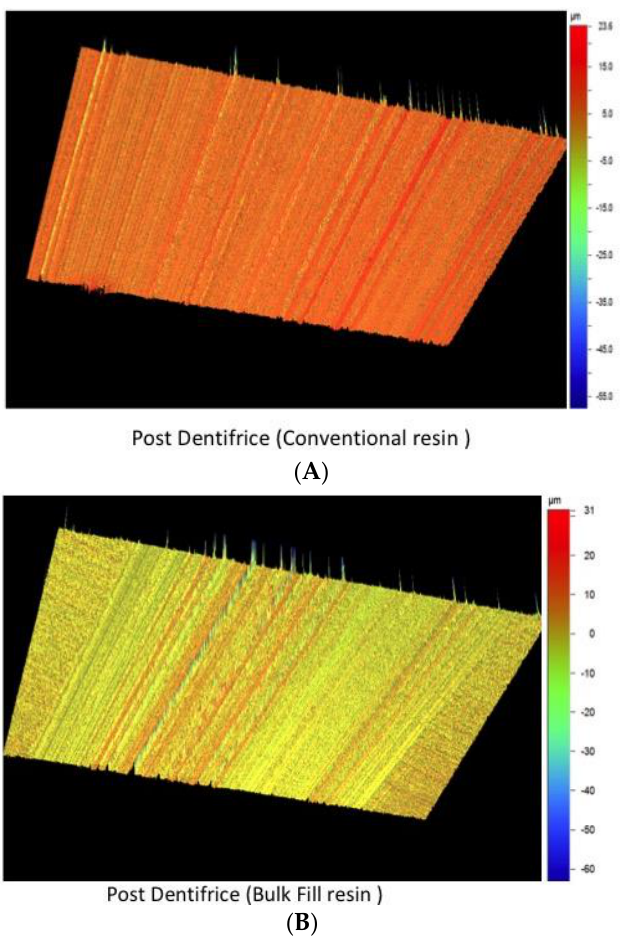
Figure 2. Surface roughness (Ra) micrograph after dentifrice exposure in conventional composite ( A ) and bulk-fill resin ( B ). Table 10. Comparison of mean surface roughness (Ra) before and after treatments among study groups.